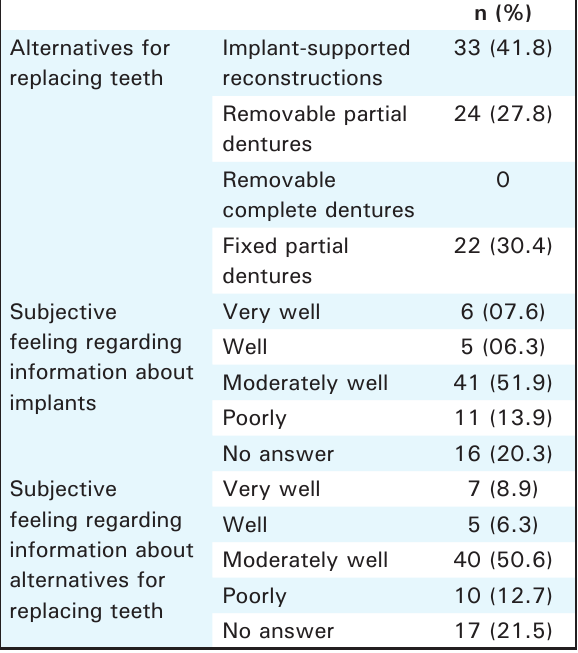
Table 2. Questions on alternatives for replacing teeth.